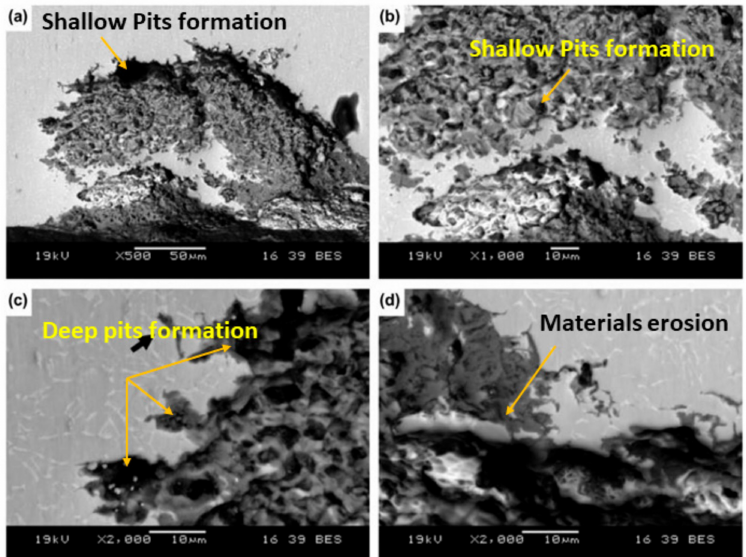
Figure 8. Effect of pitting corrosion on a neck stem device made from Ti-6Al-4V ( a , b ) showing pits formation, ( c ) displaying deep pits formation, and ( d ) material erosion due to corrosion (reproduced with permission from ref. [160]).